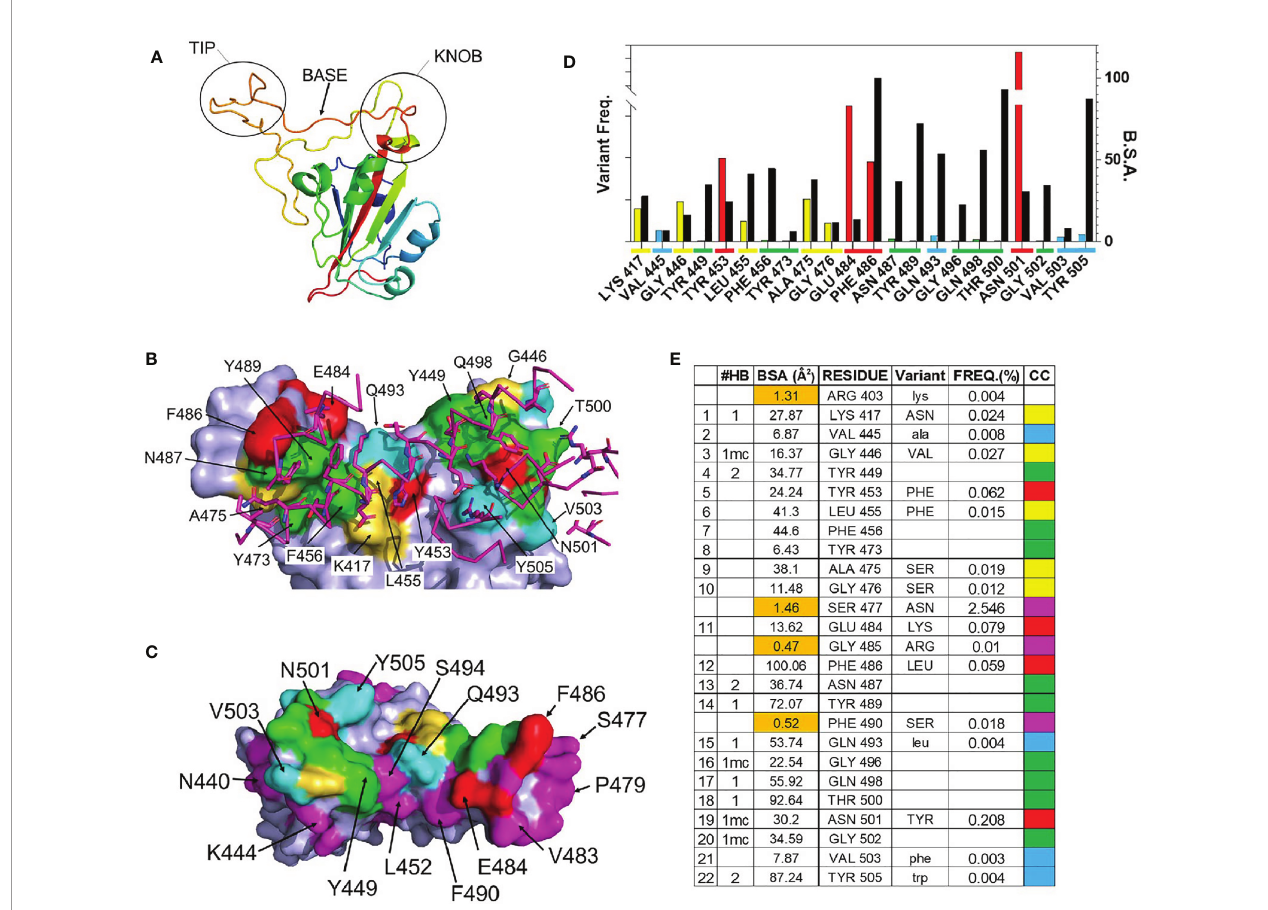
FIGURE 2 | Details of the RBD – ACE2 interaction and frequency of RBD mutations. (A) Ribbon diagram of the SARS-CoV-2 S RBD highlighting the 3 regions (tip, base, and knob) of the RBM that binds to ACE2. (B) Surface representation of the RBD ACE2 binding site (pdbid 6m0j) color coded based on amino acid variability, relative to Wuhan-1 reference sequence (see (E) for color code). The sidechains and backbone of ACE2 amino acids that contact the RBD are shown on the fi gure and colored magenta. (C) RBD ACE2 binding surface, rotated 180 degrees relative to (B) , that highlights residues adjacent to the ACE2 binding site, that exhibit amino acid variation of at least 0.01% (magenta). (D) Graphical presentation of the frequency of RBD variant occurrences in the GISAID (left axis, colored bars), relative to buried surface area (BSA, right axis) presented as black bars. Coloring described in (E) . (E) Parameters of the RBD-ACE2 binding site. The 22 RBD residues of the ACE2 binding site and four residues (<2Å 2 BSA, orange) that are not part of the ACE2 binding site. The types of hydrogen bonds made by each residue is listed under #HB, where bivalent sidechain hydrogen bonds = 2, monovalent sidechain hydrogen bonds =1, and mainchain hydrogen bonds are denoted by “ mc ” . The frequency (FREQ) that variant RBD amino acids (variant) are observed in the SARS-CoV-2 S GISAID sequence database, relative to the Wuhan-1 reference sequence is reported. The color code (CC) for (B – D) is also